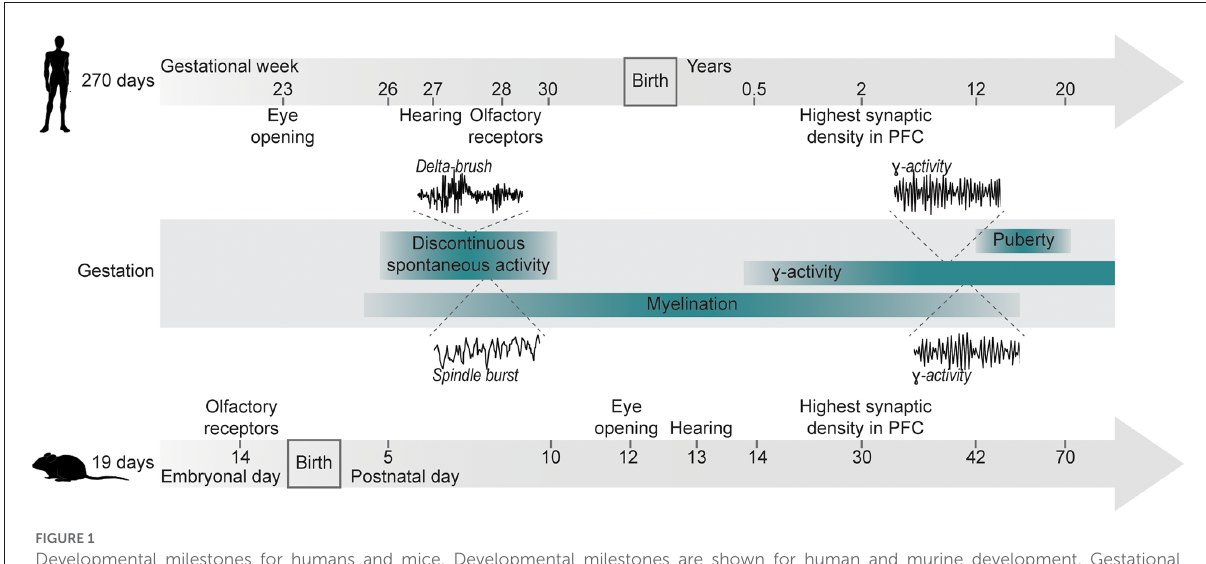
FIGURE1 Developmental milestones for humans and mice. Developmental milestones are shown for human and murine development. Gestational durations are indicated on the left. Anatomical milestones (eye opening, development of hearing, expression of olfactory receptors) are indicated for each time line individually. Shared developmental processes (discontinuous activity, γ -activity, myelination) are indicated as age-matched ranges for both species. Insets depict examples of delta-brushes in humans [modified from Milh et al. (2007)] and spindle bursts in mice [modified from Shen and Colonnese (2016)] during early discontinuous activity, as well as filtered γ -oscillation in humans [modified from Synigal et al. (2020)] and in mice [modified from Bott et al.